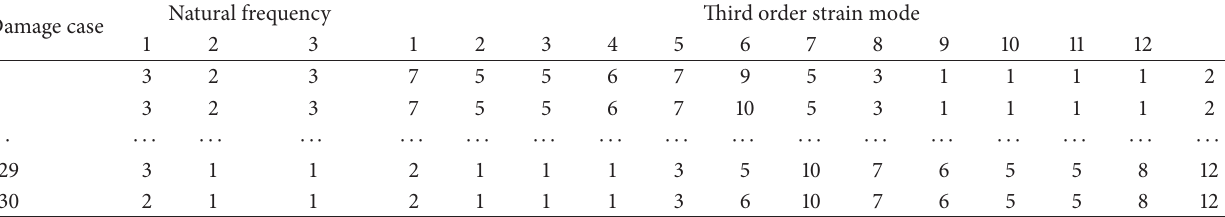
Table 9: Attribute set 3 rules generation for damage